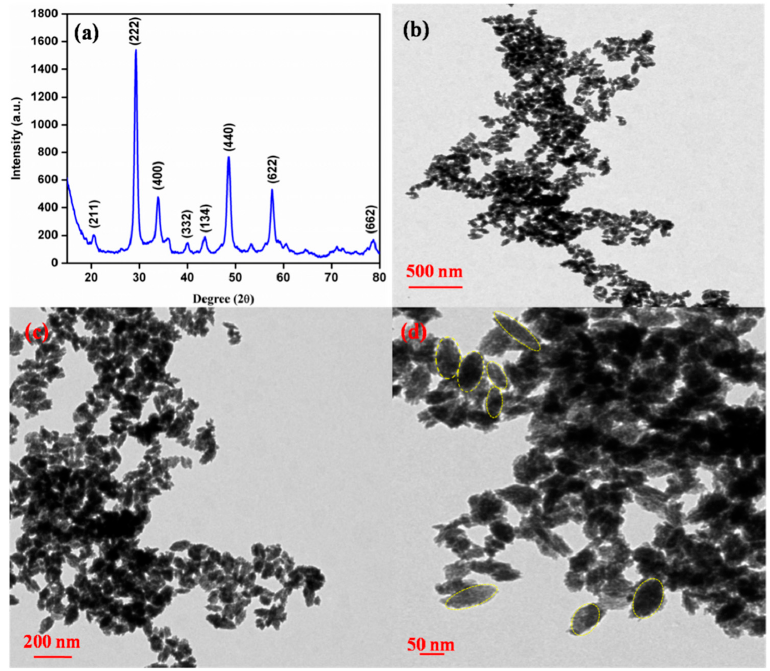
Figure 1. ( a ) XRD graph of nY 2 O 3 . TEM images of nY 2 O 3 at scale bar of ( b ) 500 nm, ( c ) 200 nm, and ( d ) 50 nm.